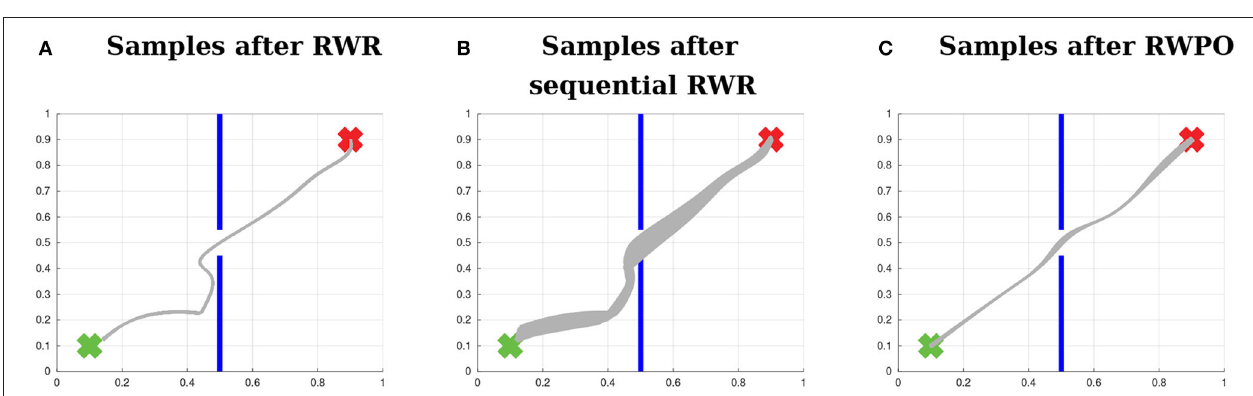
FIGURE 11 | Comparison between Reward-weighted Regression (RWR), sequential Reward-weighted Regression (sRWR) and Relevance Weighted Policy Optimization (RWPO). This time, the three algorithms optimize the distribution over trajectories with respect to all objectives. (A) Distribution after optimization with RWR, which uses a single reward function with a term for each objective. (B) Distribution after optimization using sRWR, which optimizes for each objective sequentially and has a reward function for each objective. (C) Distribution after optimization using RWPO, which uses the concept of relevance functions and optimizes for each objective sequentially with a reward function for each